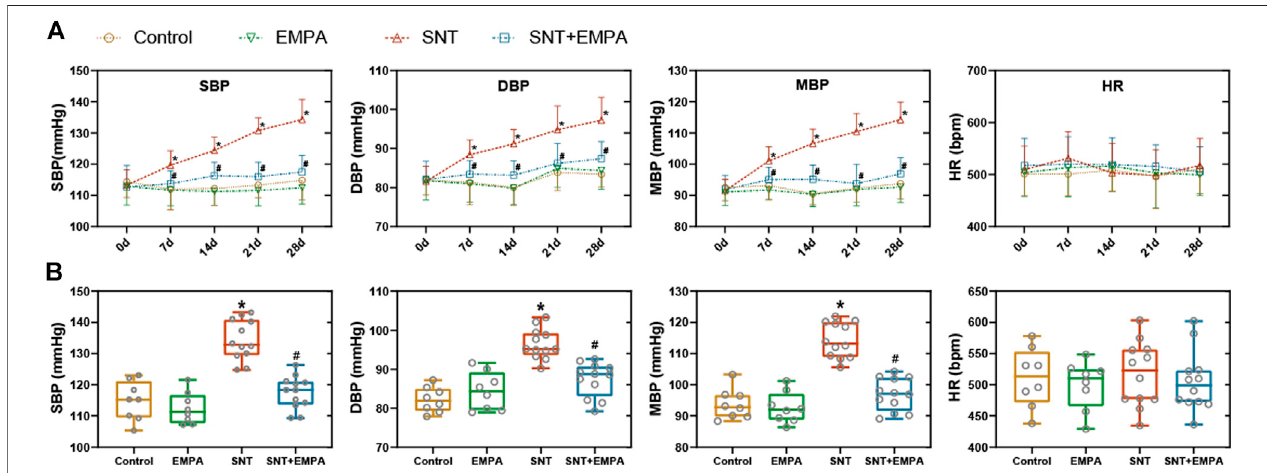
FIGURE 1 | Effects of EMPA on blood pressure in SNT-treated mice. (A) Changes of blood pressure (SBP, DBP, and MBP) and HR during the modeling process among different groups, n (cid:1) 8 or 12 per group. (B) Blood pressure (SBP, DBP, and MBP) and HR at the study endpoint among different groups, n (cid:1) 8 or 12 per group. * p < 0.05 vs. control, # p < 0.05 vs. SNT.